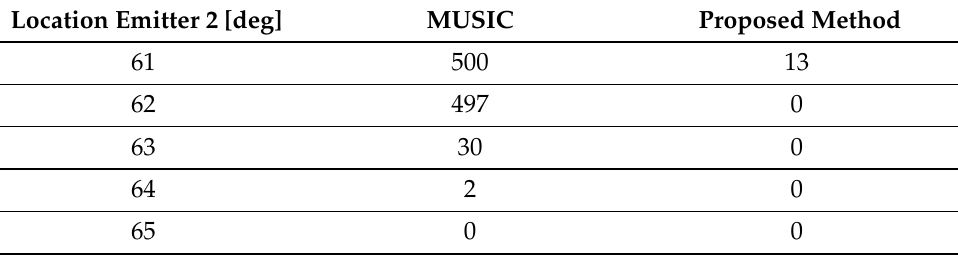
Table 1. Number of Failures in 500 Trials with Respect to Emitter 2 Location. SNR = 5 dB, 100 snapshots. Location Emitter 2